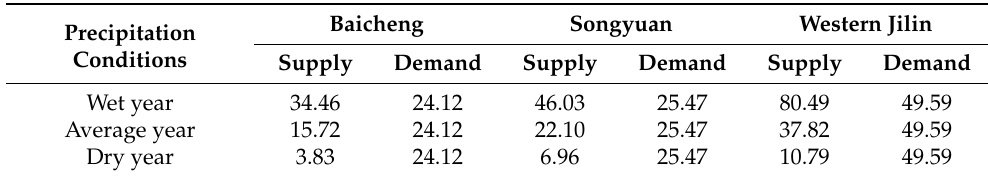
Table 6. Water supply-and-demand quantification table in different precipitations in western Jilin (10 8 m 3 ).